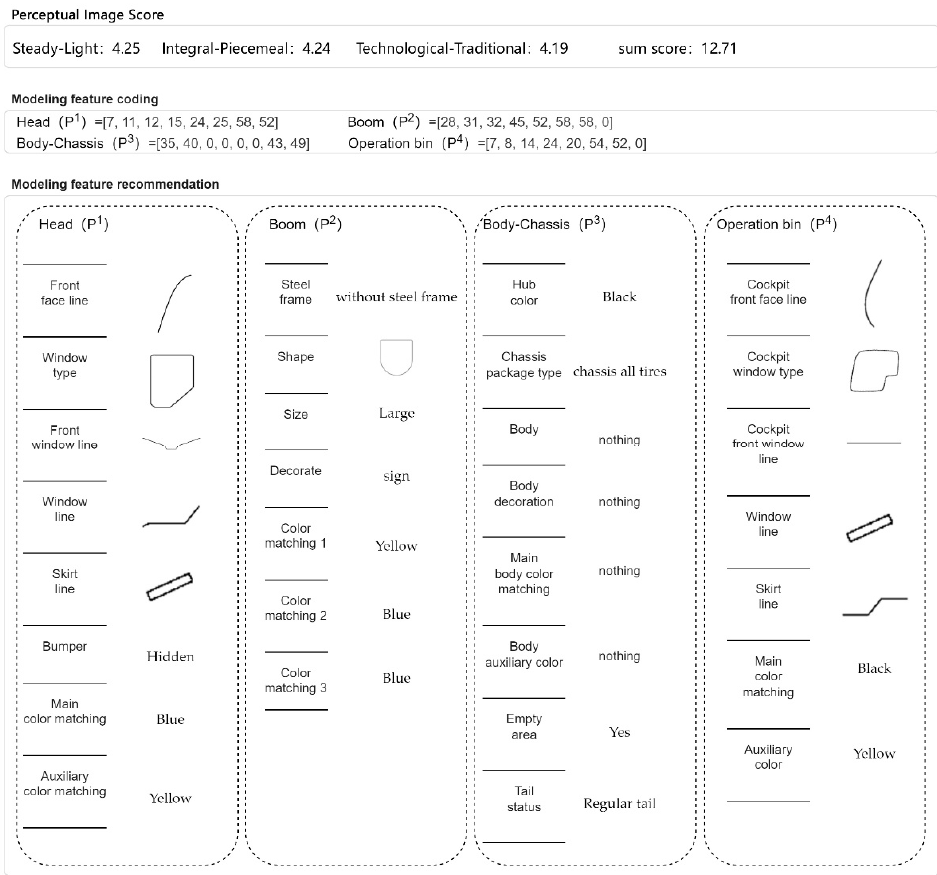
Figure 11. Iteration diagram of the GA model.